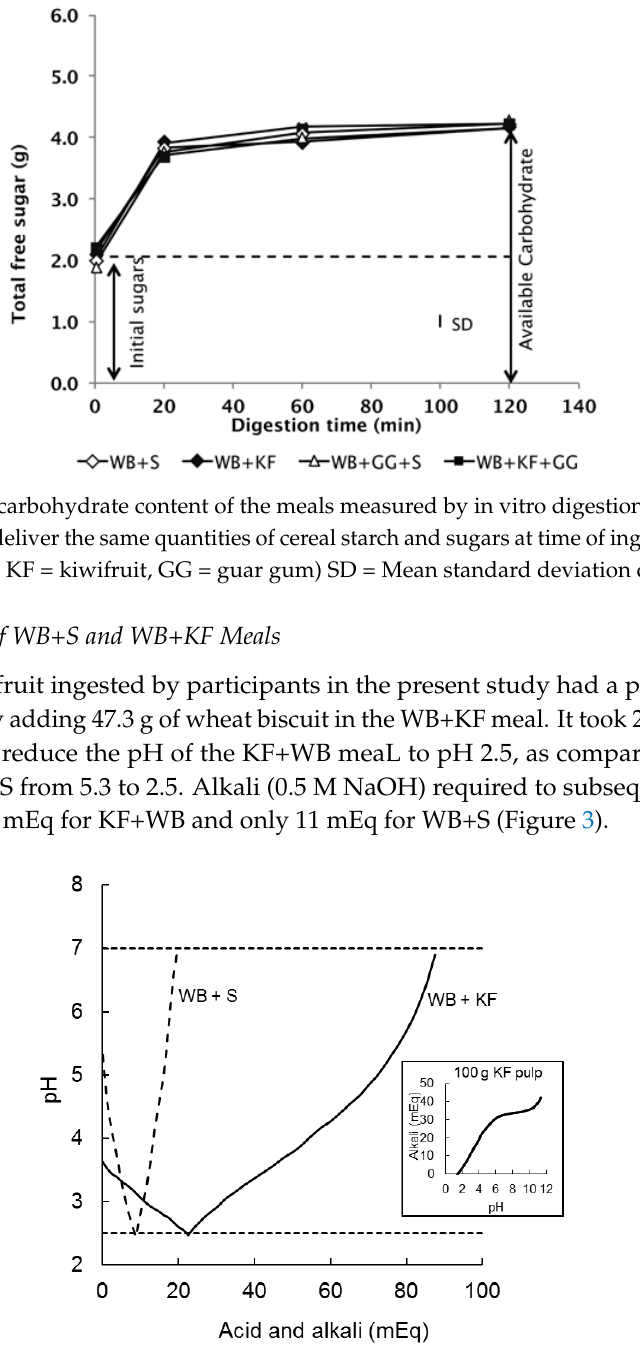
Figure 3. Acid and alkali (milliequivilants) required to reduce the pH of meals ingested from their initial pH to pH 2.5 (with 0.5 M HCl) and to subsequently raise it to pH 7.0 (with 0.5 M NaOH). WB+S (dashed line) was 47.3 g wheat biscuit +20 g sugars; KF+WB (solid line) was 200 g kiwifruit + 47.3 g wheat biscuit. The inset graph shows the typical titration curve of a weak acid with a strong alkali for 100 g kiwifruit pulp, indicating buffering capacity of kiwifruit flesh.